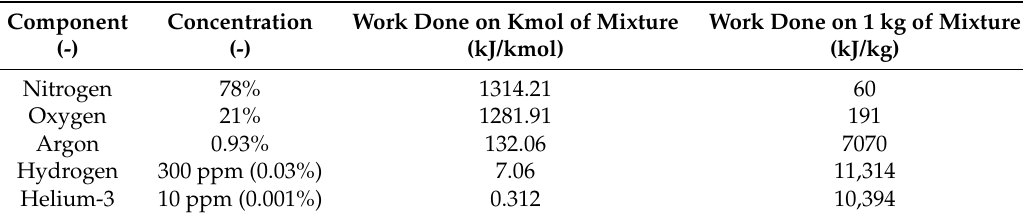
Table 6. Minimal work of separation for gases [25].